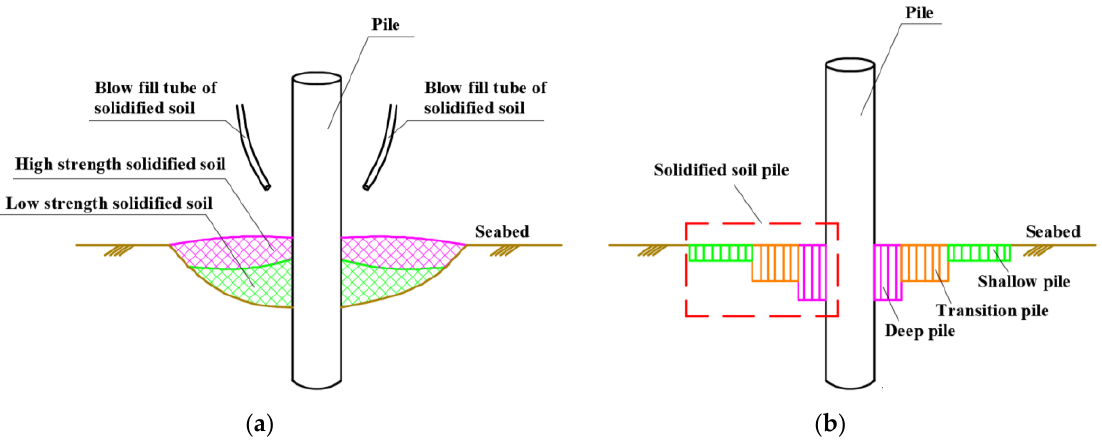
Figure 3. Schematic diagram of solidified soil protection. ( a ) In situ solidification ( b ) Ex situ solidi- fication.